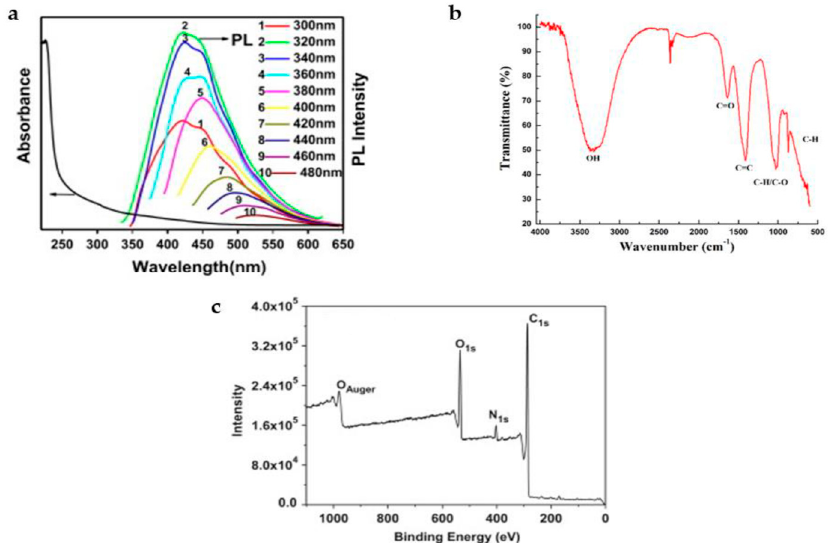
Figure 3. ( a ) UV-Vis absorption spectrum (left) and photoluminescent emission spectra of plant soot-based CDs at several excitation wavelengths; ( b ) FTIR spectrum of Fennel seeds-based CDs; ( c ) XPS spectrum of plant soot-based CDs. Reproduced with authorization from